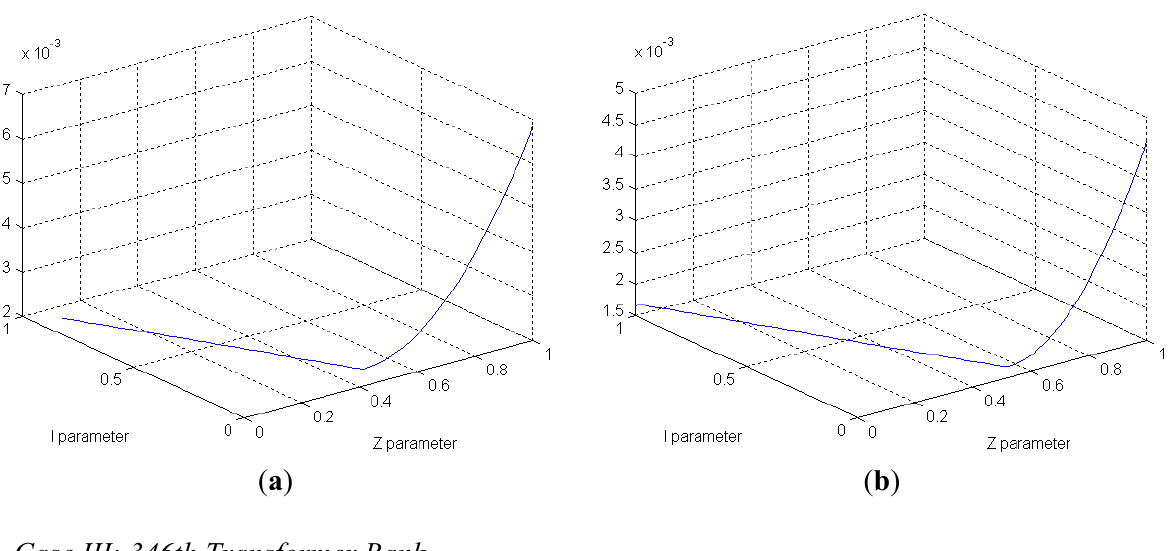
Figure 4. Results for the 1509th transformer bank on summer days: ( a ) minimum active objective function errors according to the variation in p function errors according to the variation in q